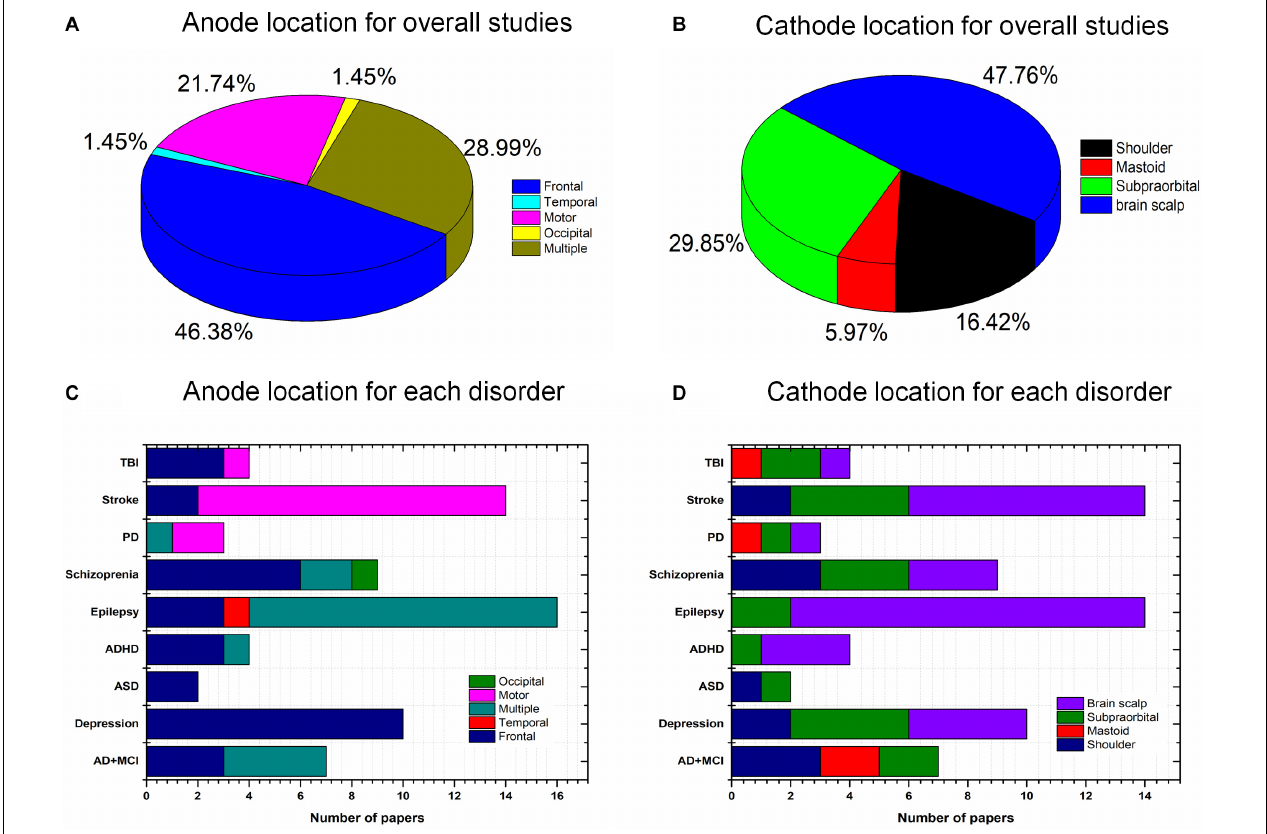
FIGURE 7 | Anode and cathode distributions: (A) Anode (overall), (B) cathode (overall), (C) anode locations for individual diseases, and (D) cathode locations for individual